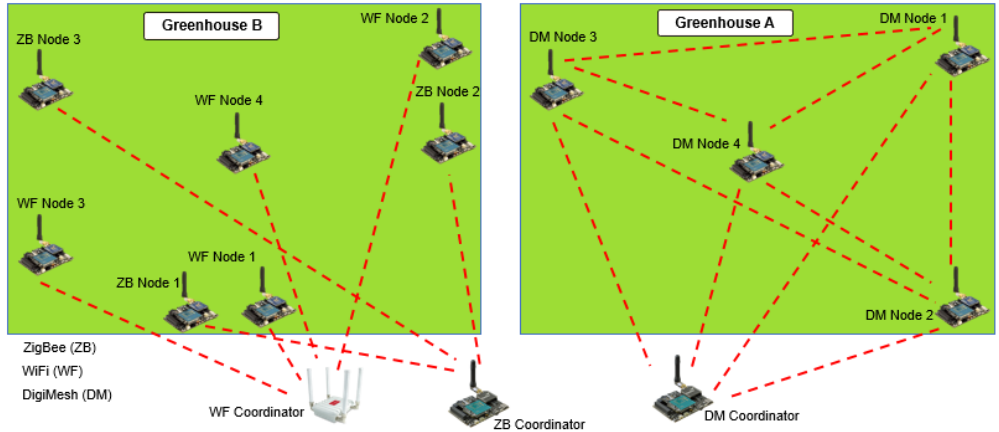
Figure 7. Map of WSNs distribution and node locations.